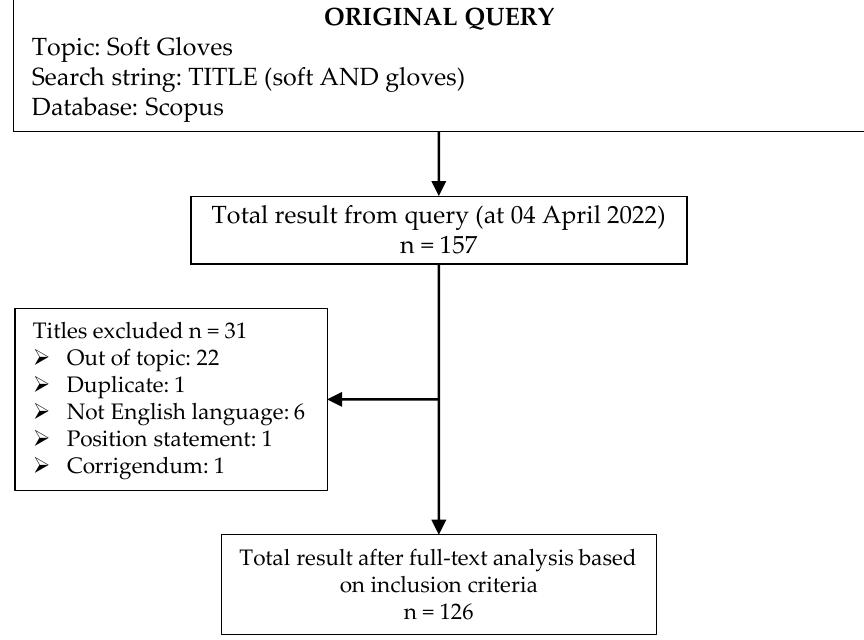
Figure 4. Flow chart which maps the selection process, with the number of records identified, included and excluded, and the reasons for